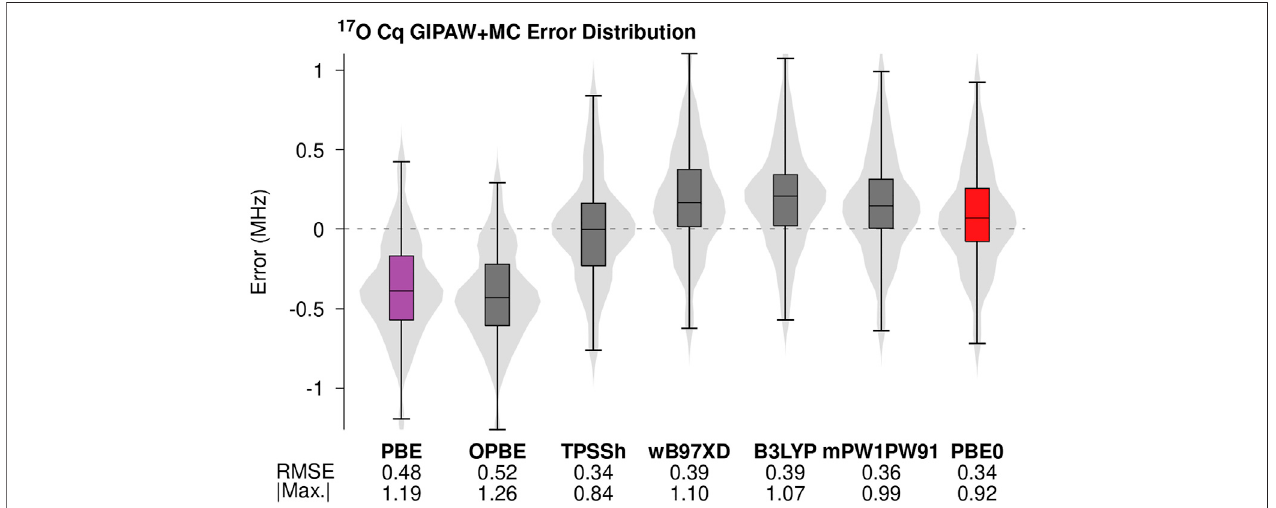
FIGURE 4 | Percent improvement in the RMS error (red) and the maximum absolute error (blue) for GIPAW + MC calculations relative to GIPAW/PBE. Results are reported for the 17 O quadrupole coupling constant ( C q ), the isotropic chemical shift ( σ iso ), and the CSA tensor components ( σ ii ). The molecular correction for the GIPAW + MC calculations were performed at the PBE0/6 – 311+G (2d,p) level.